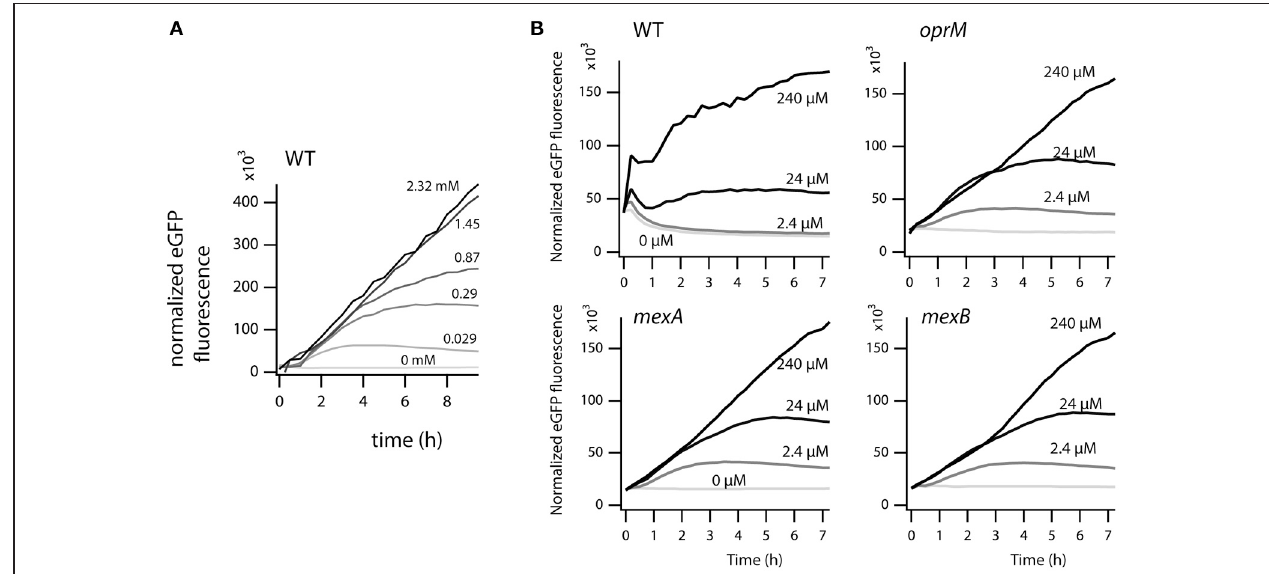
HBP1 wild-type compared to mexB ::Km, mexA:: Km and oprM:: Km insertion mutants transformed with pME6012_hbpR_gfp exposed or not to 2-HBP at 2.4, 24, or 240 μ M. The GFP fluorescence signal is normalized by the culture density at every time